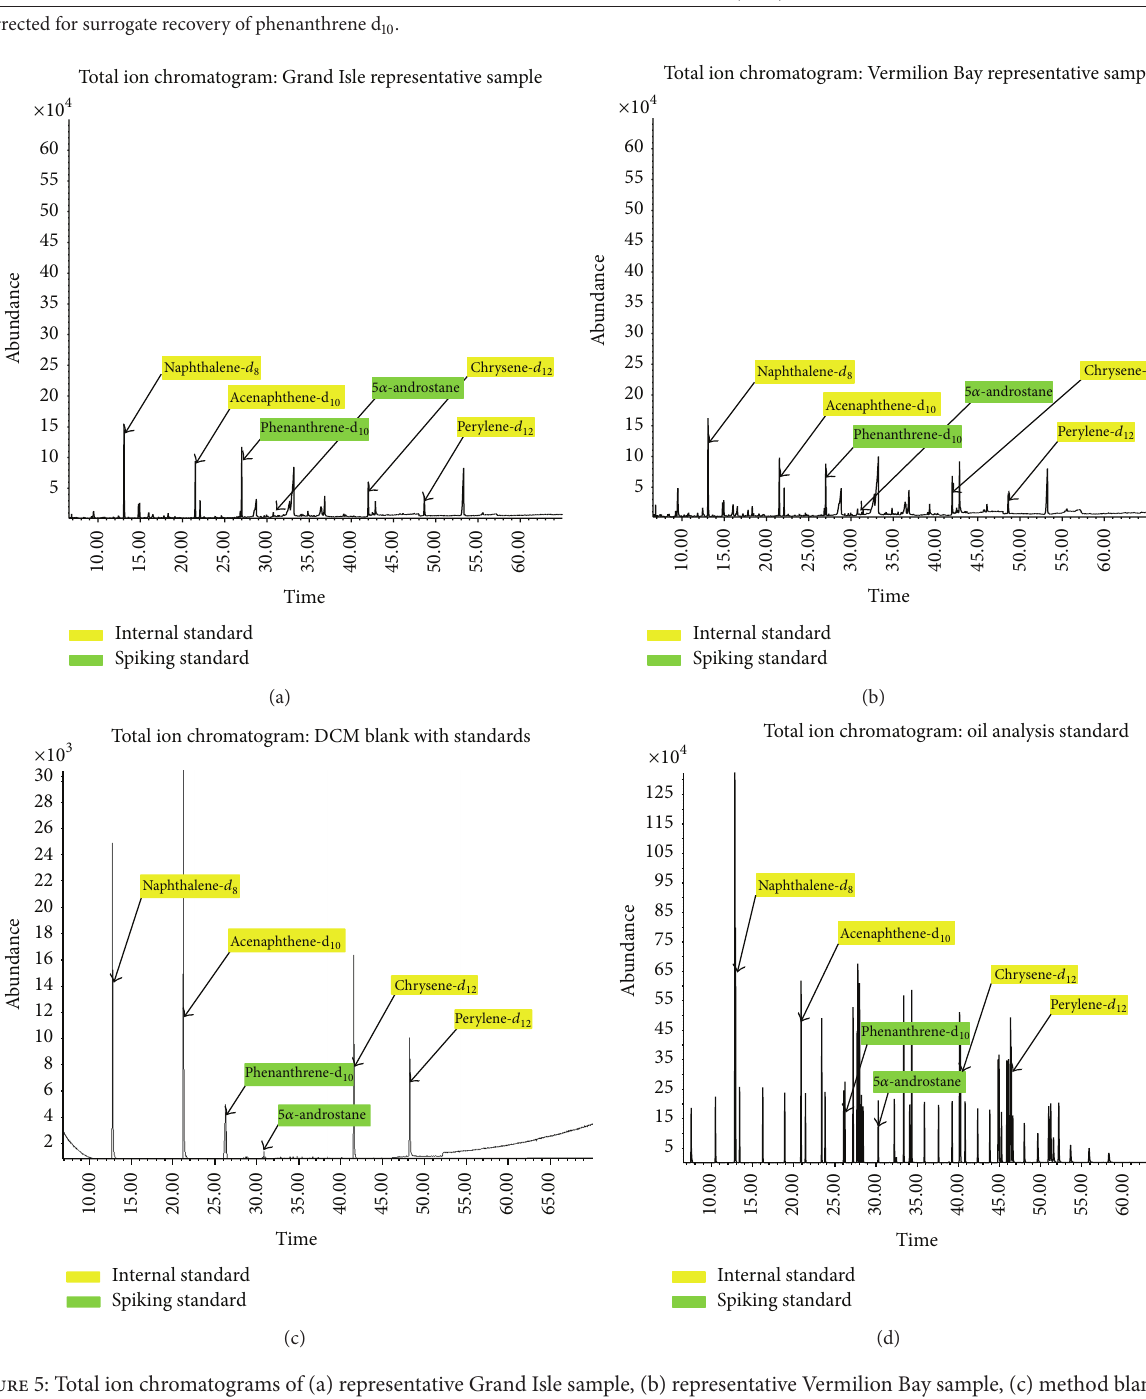
Table 2: Assessment of phenanthrene d